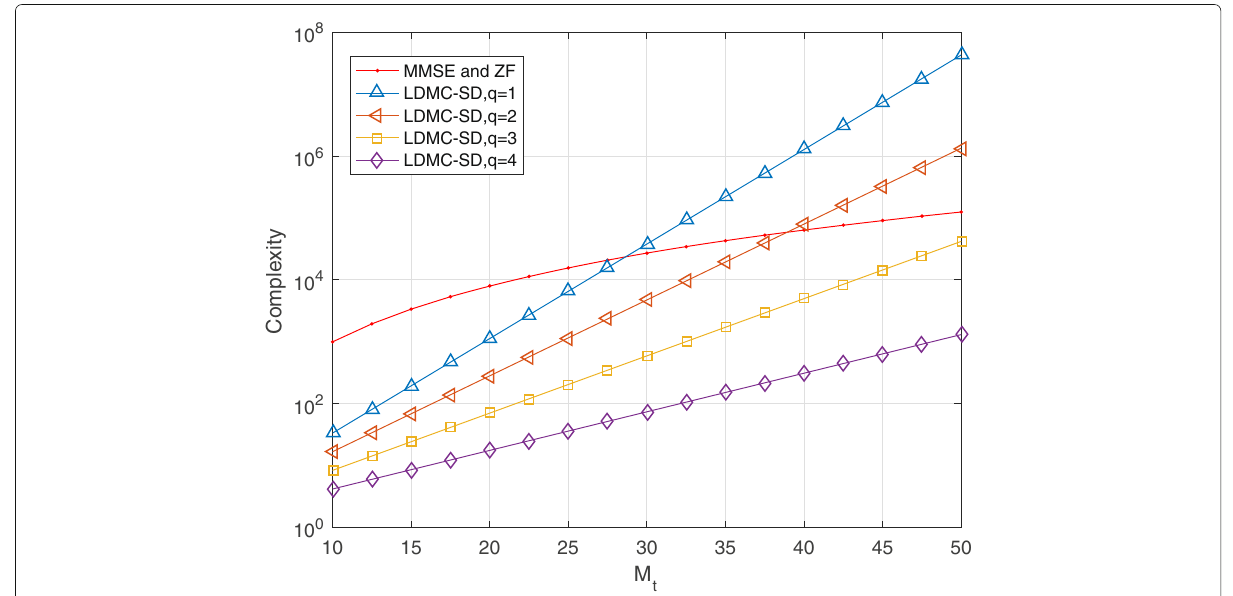
Fig. 1 Complexity comparison of MMSE, ZF, and LDMC-constrained SD detections for varying M t and q